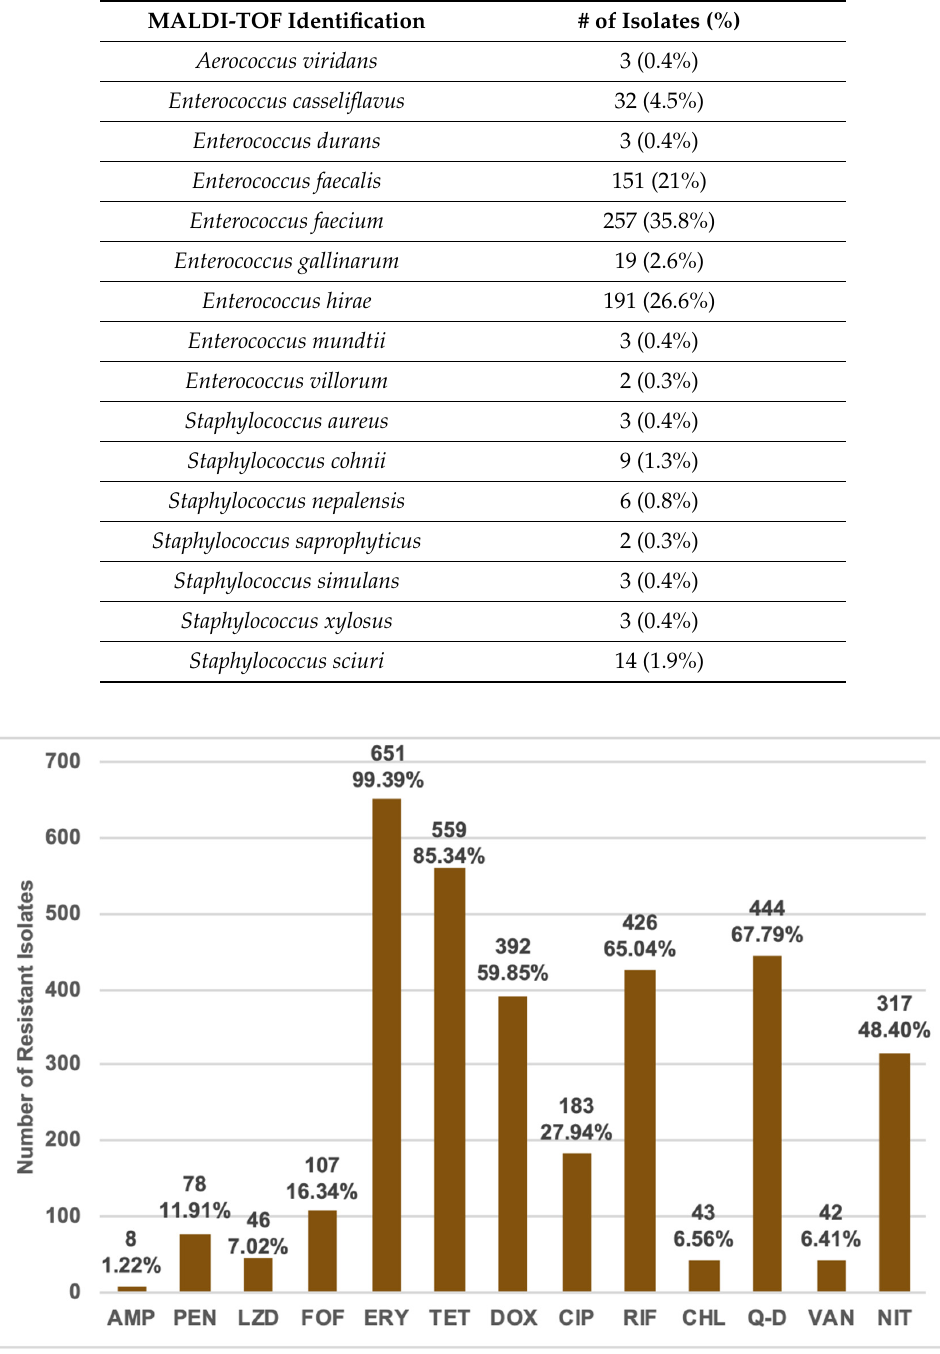
Figure 1. Numbers and percentages of total resistant enterococci for each of the tested antimicrobials. Additionally, 59.85% of the isolates were resistant to doxycycline and 48.40% were resistant to nitrofurantoin. Few of the isolates displayed resistance to fosfomycin, chloramphenicol, and ampicillin at 16.34%, 6.56%, and 1.22%, respectively (Figure 1).